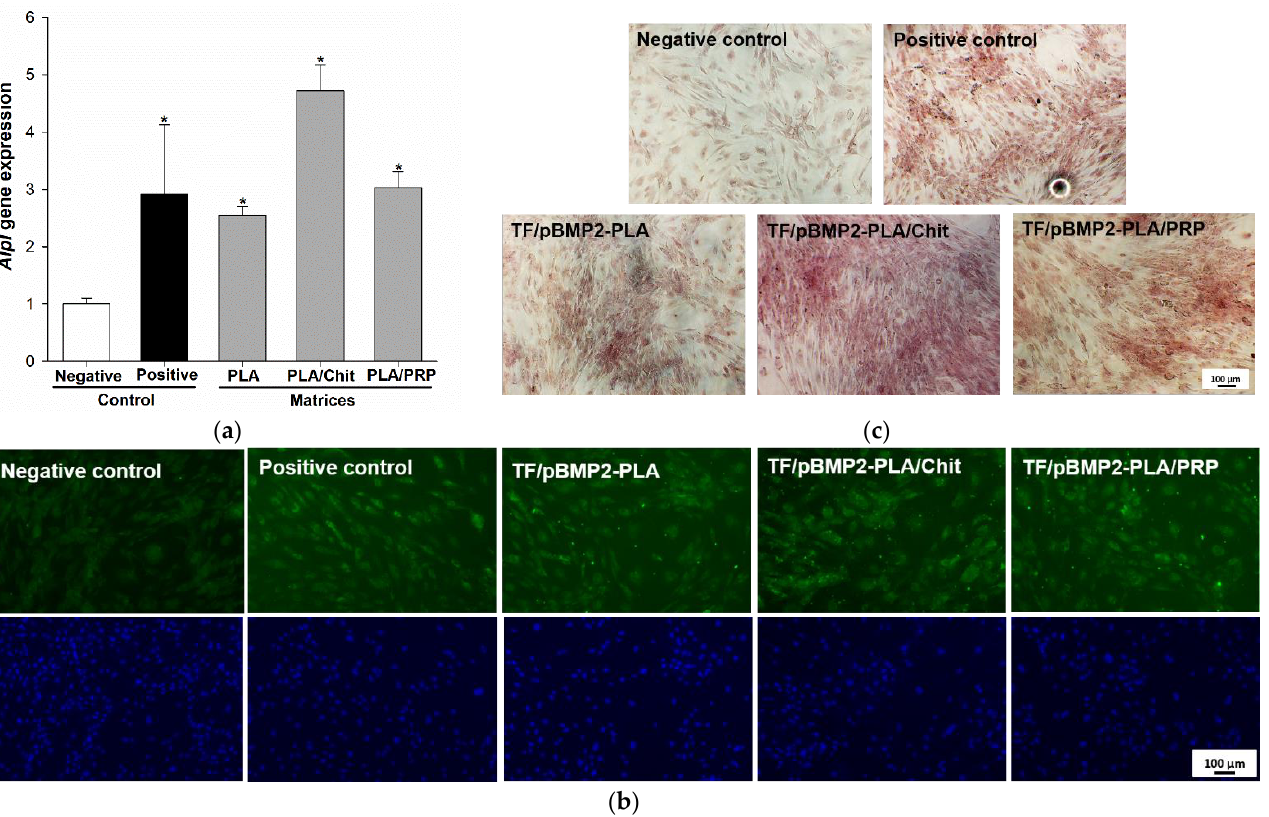
Figure 6. Osteoinductive properties of TF/pBMP2-Matrices 14 days after incubation with MSCs: ( a ) relative Alpl gene expression, RT-PCR. * p < 0.05 (relative to negative control); ( b ) Alpl protein production (green), nuclei (blue) ICH; and ( c ) ECM mineralization of MSCs, alizarin red staining.